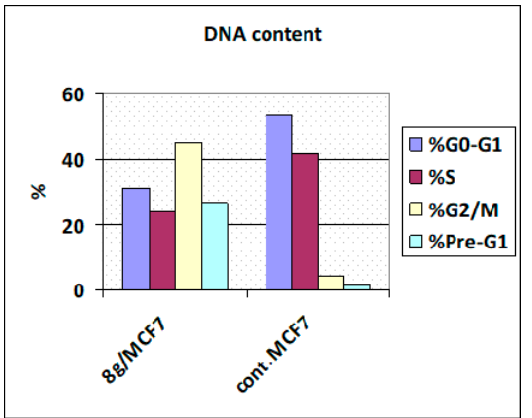
Figure 5. Cell cycle analysis in MCF-7 cell line treated with compound 8g .